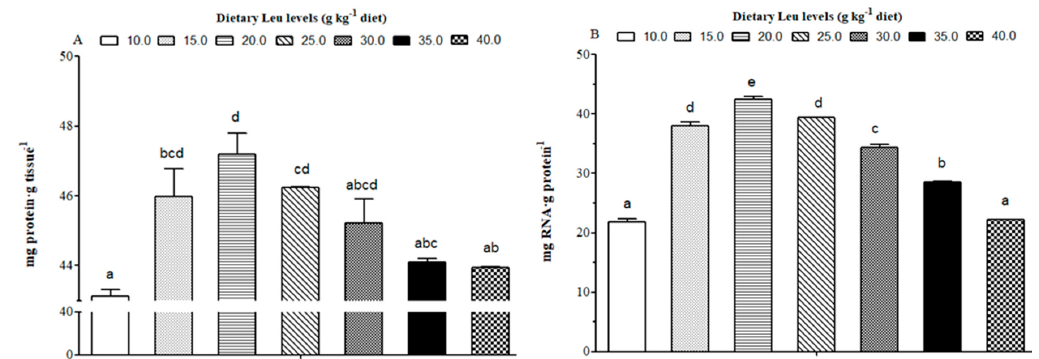
Figure 3. Effect of dietary Leu on protein content (mg protein ∙ g tissue − 1 ( A )) and RNA/protein ratio (mg RNA ∙ g protein − 1 ( B )) in hybrid catfish muscle. Data represent means ± SEM of three replicates, with six fish in each replicate. Values having different letters are significantly different ( P < 0.05).